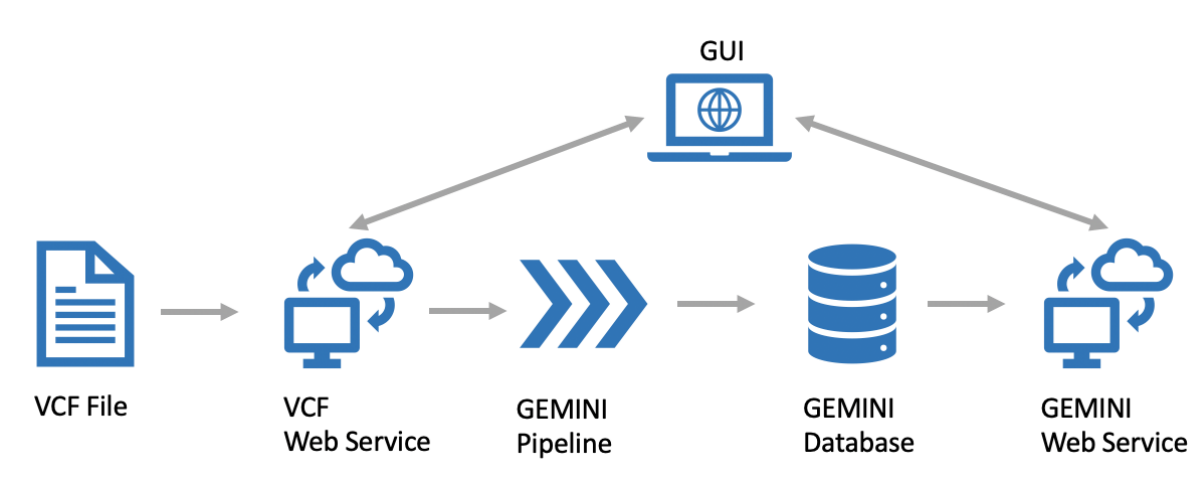
Figure 2. Part 1: Next-generation sequencing processing and analysis pipeline architecture. GUI: graphical user interface; VCF: variant call format; GEMINI: GEnome MINIng.